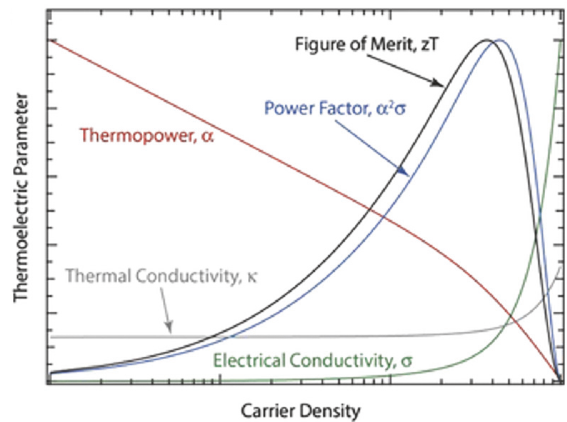
Figure 1: Schematic showing the coupled dependence of the various TE properties on carrier density. The shape of each individual curve was extracted from actual data on single-walled carbon nanotube networks. Figure reproduced with permission